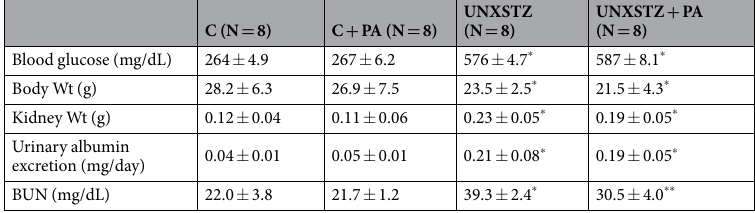
Table 1. Body weight, kidney weight, and 24-h urinary albumin excretion in type I diabetes mellitus (DM) mice. C, control; PA, periostin-binding DNA aptamer; UNXSTX, uninephrectomized STZ-induced DM mice;